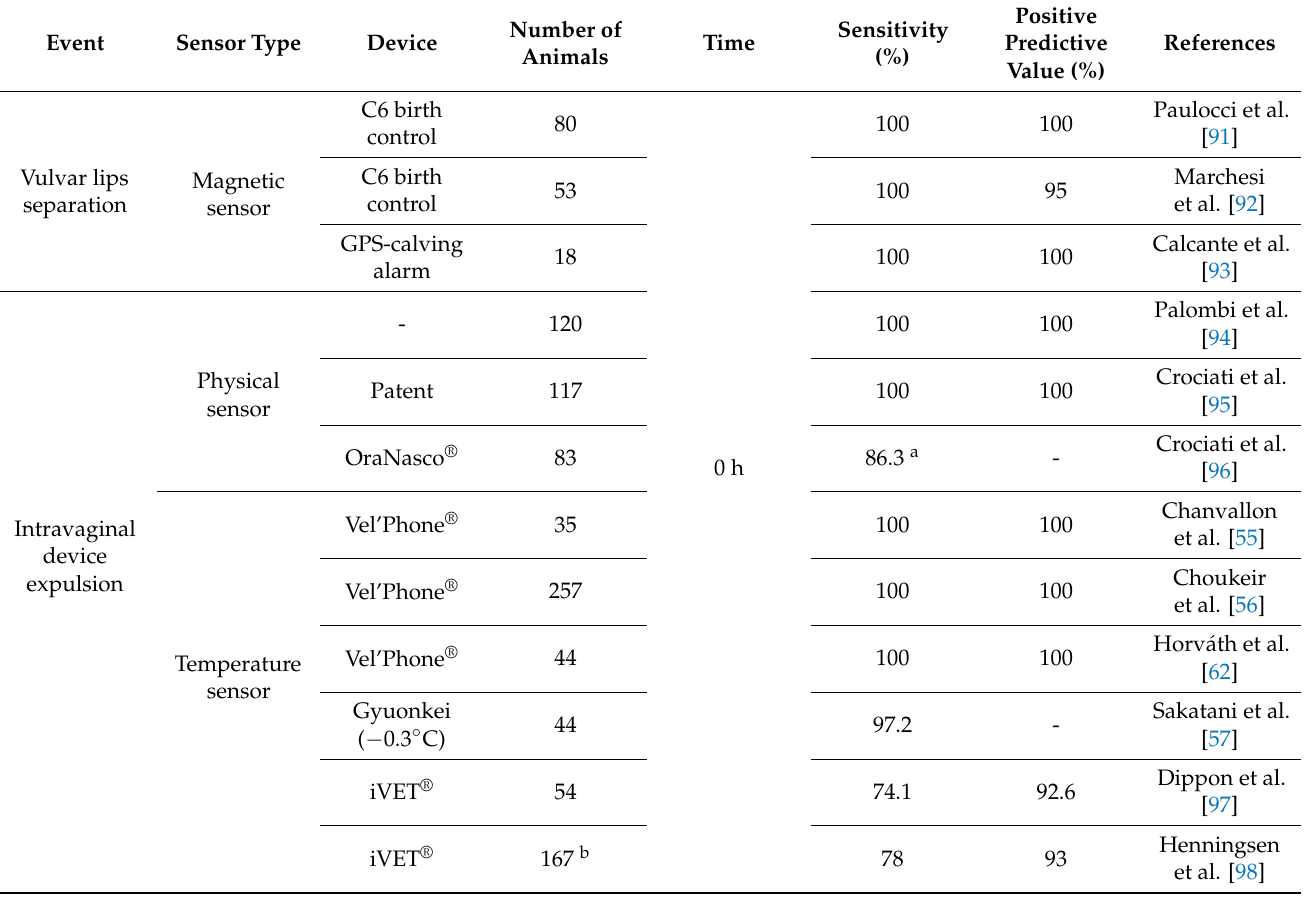
Table 5. Accuracy to detect the expulsion of the sensors during appearing of the allantochorion at the beginning of 2nd stage of calving in dairy